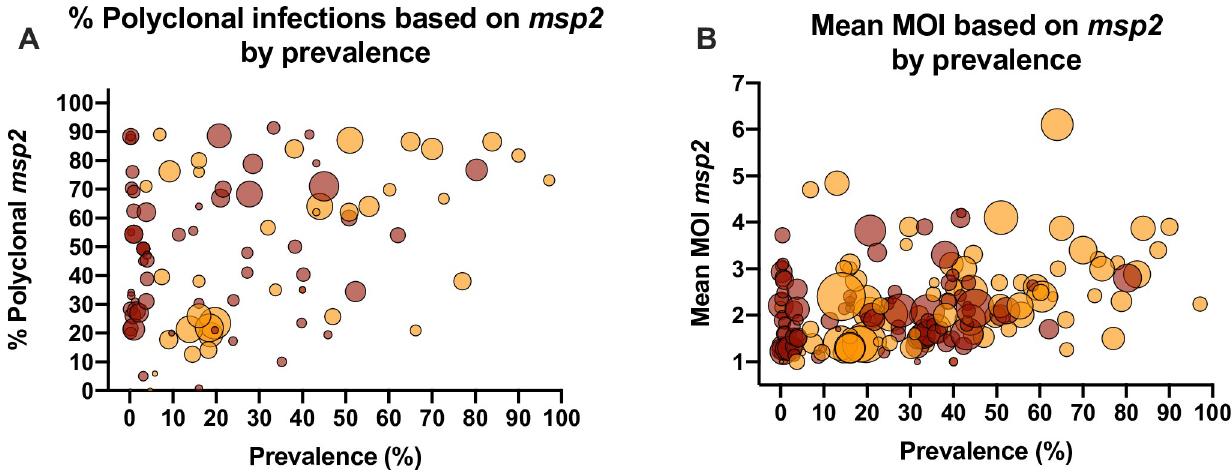
Fig 4. Relationship between the proportion P . falciparum polyclonal infections (A) or mean multiplicity (B) and prevalence based on typing of marker msp2 . Dot sizes represent the number of individuals genotyped. Dark red = samples collected form clinical patients. Orange = samples collected form asymptomatic individuals. Overlapping data points result in darker